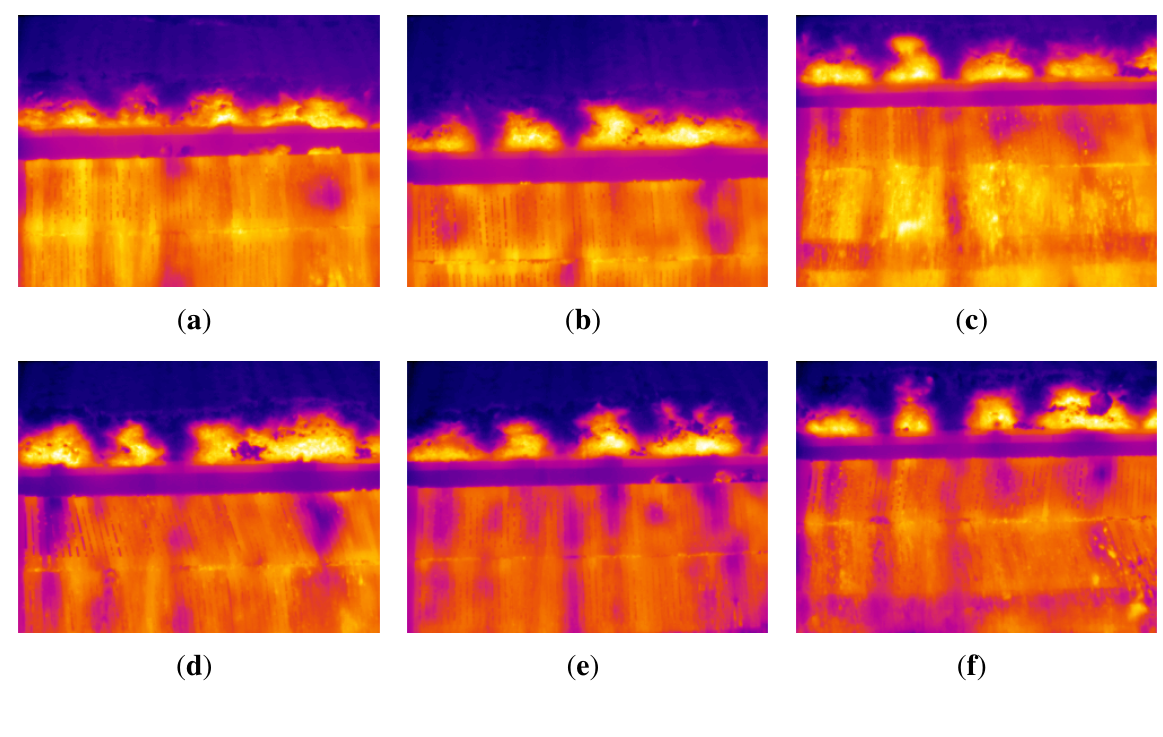
Figure 7. Examples of detected key frames. ( a ) Frame 1; ( b ) Frame 2; ( c ) Frame 3; ( d ) Frame 4; ( e ) Frame 5; ( f ) Frame